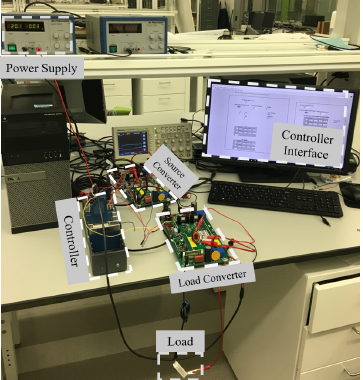
Figure 14. Experimental prototype set-up.